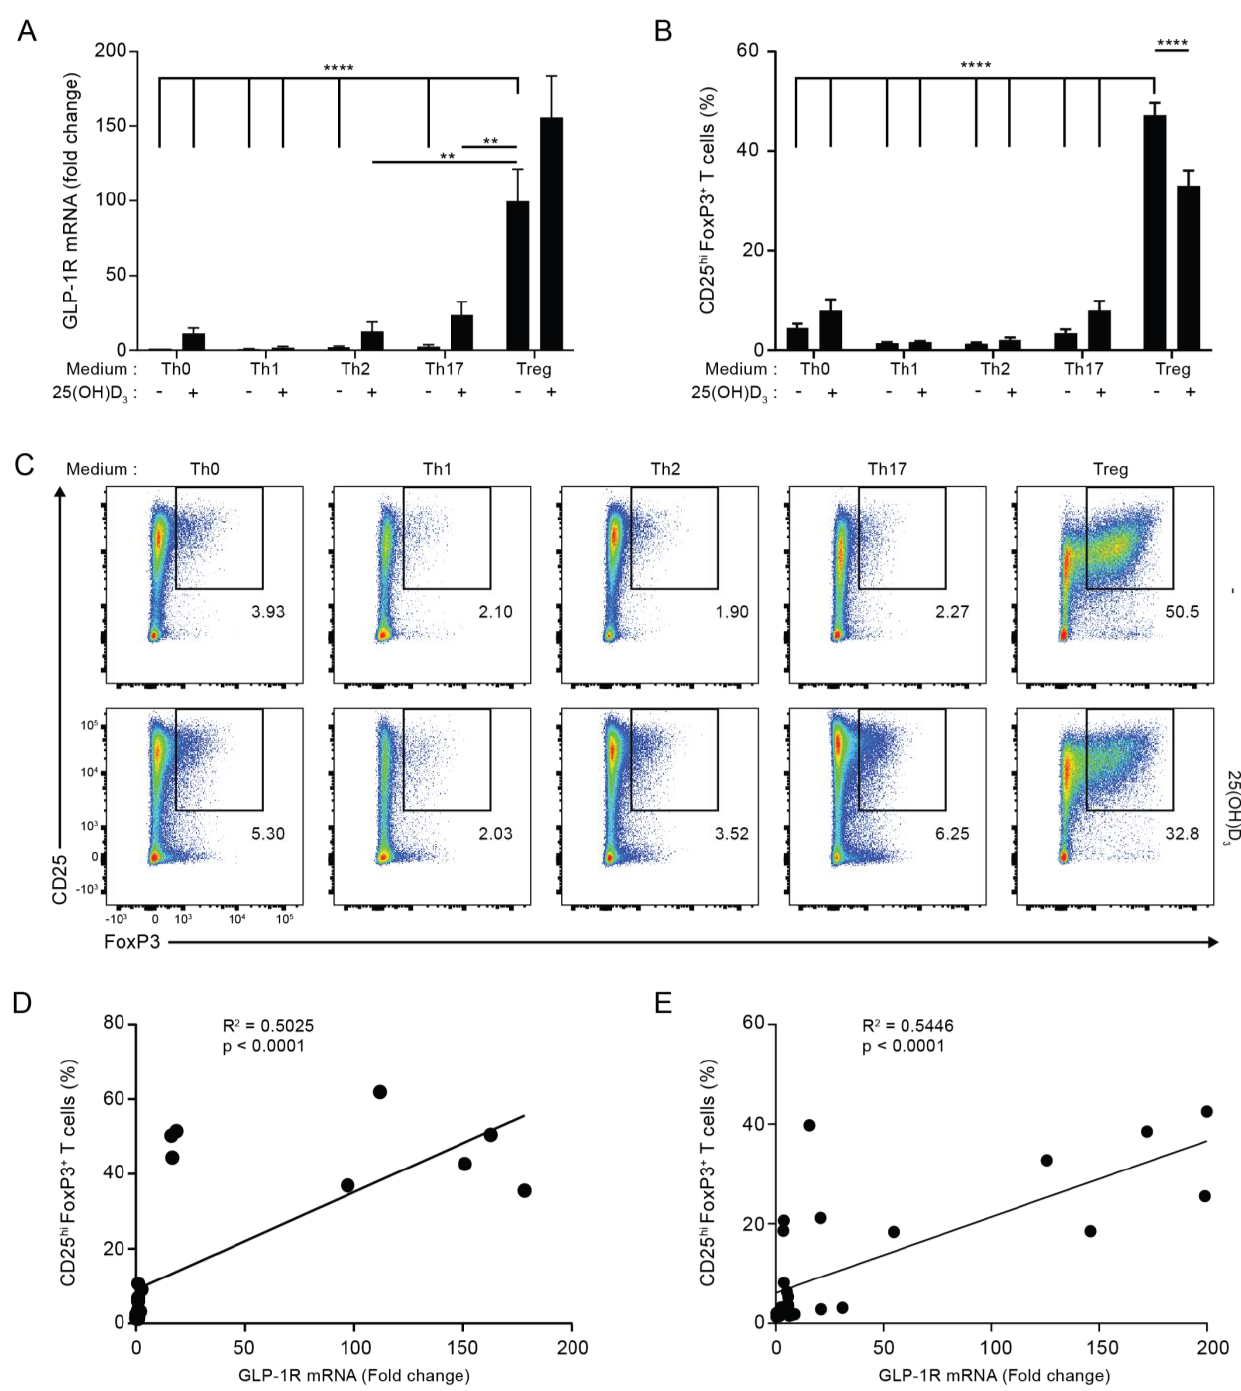
Figure 2. GLP-1R expression directly correlates with the percentage of CD25 + FoxP3 + T cells. ( A ) Relative GLP-1R expression, ( B ) percentage of CD25 + FoxP3 + T cells and ( C ) representative flow cytometric analysis of CD4 + T cells activated for 120 h in the indicated polarization medium in the absence or presence of 25(OH)D 3 (100 nM). GLP-1R expression was normalized to GLP-1R expression in CD4 + T cells activated for 120 h in Th0 medium in the absence of 25(OH)D 3 (mean + SEM, n ≥ 4, one -way ANOVA with post- hoc test (Dunnett’s), ** p < 0.005, **** p < 0.00005. The mean of each column was compared with the mean of the column for Treg minus vitamin D). Data presented in ( B , C ) were obtained by gating on live, single lymphocytes as shown in Figure S2. The percentage of CD25 hi FoxP3 + CD4 + T cells correlated with the expression level of the GLP-1R in CD4 + T cells acti- vated for 120 h in the indicated differentiation media in both the absence ( D ) and presence ( E ) of 25(OH)D 3 (100 nM) as determined by linear regression analysis. Treg cells are characterized as being CD4 + CD25 + FoxP3 + T cells. We found that CD4 + T cells activated under Th0, Th1, Th2 and Th17 conditions contained 2 – 9% CD25 + FoxP3 +